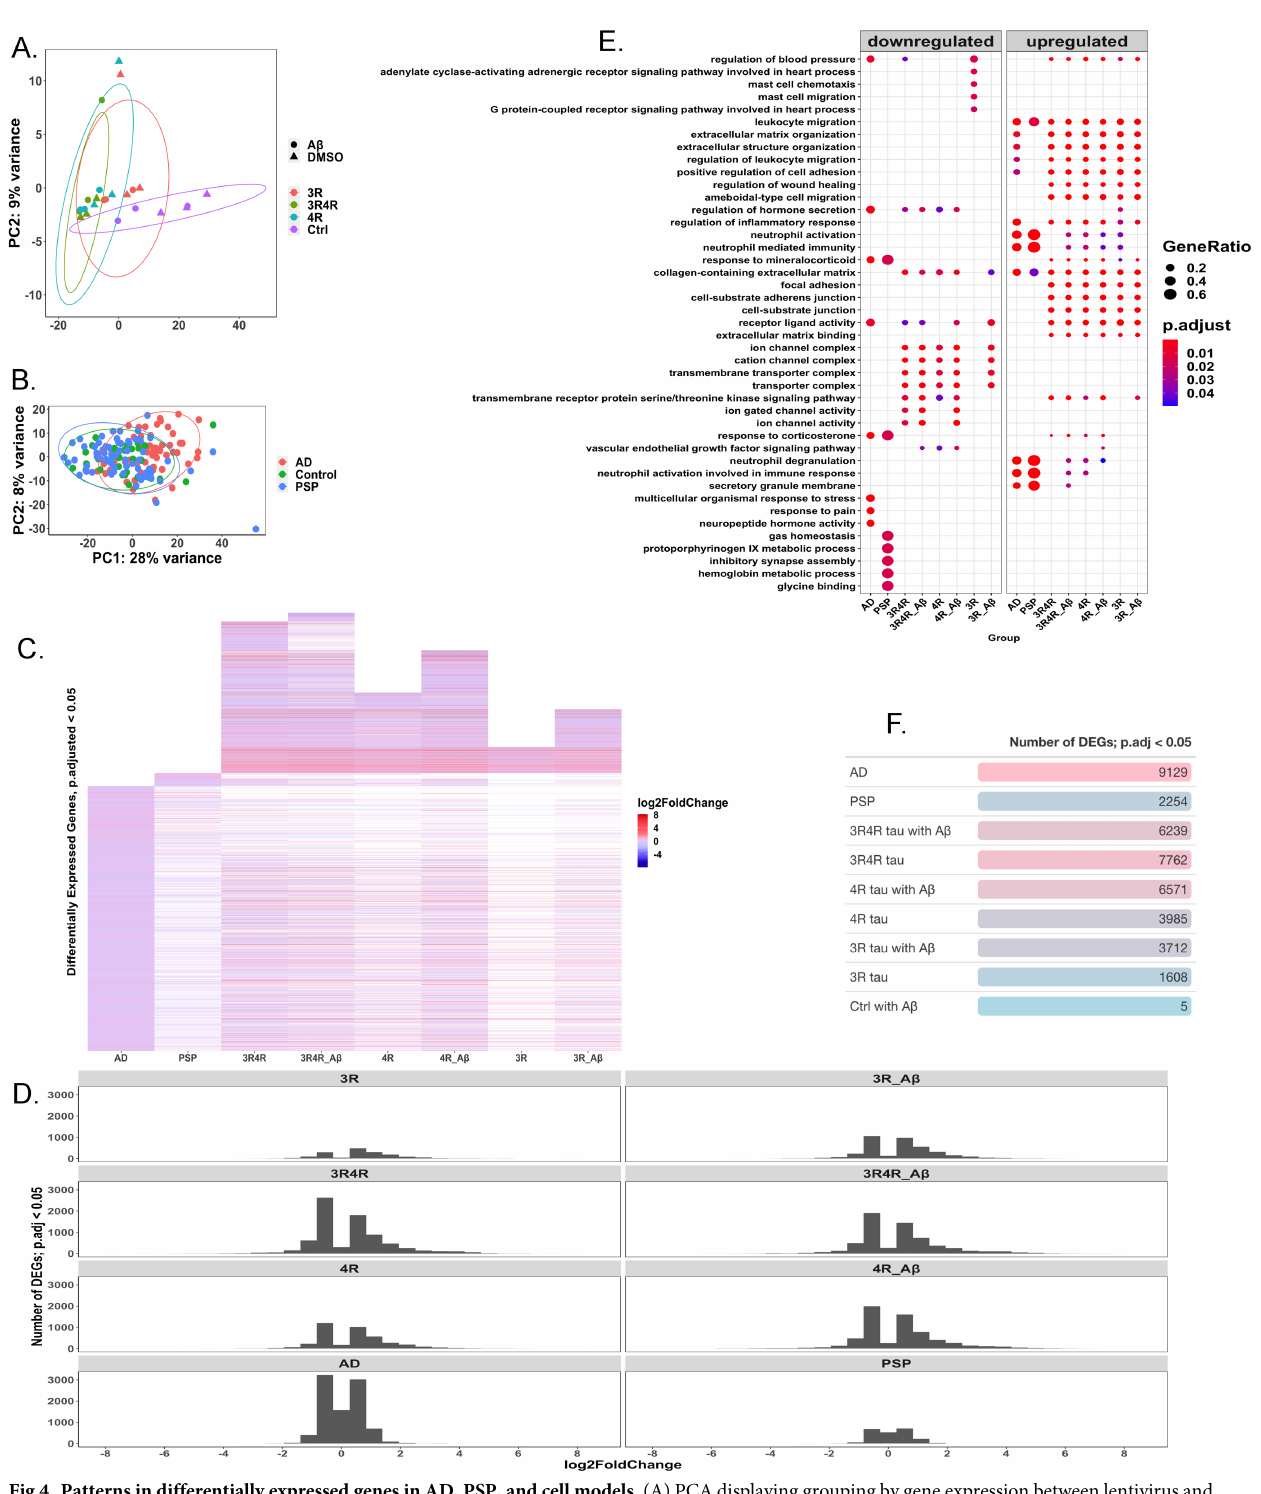
PLOS ONE | https://doi.org/10.1371/journal.pone.0251611 September 29,